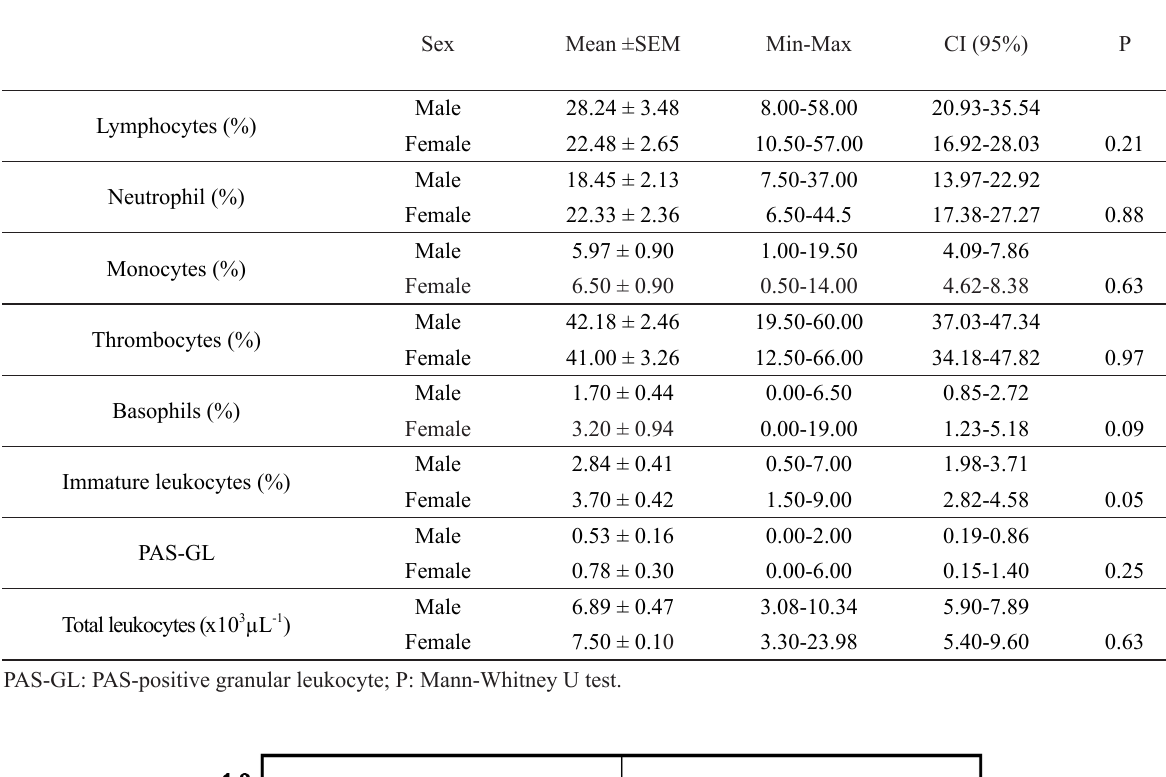
Means, standard error of the means (SEM), minimum (Min) and maximum (Max) values and confidence intervals (CI 95%) of leukocytes and thrombocytes and total leukocytes of male and female tuvira Gymnotus inaequilabiatus from Brazilian Pantanal.